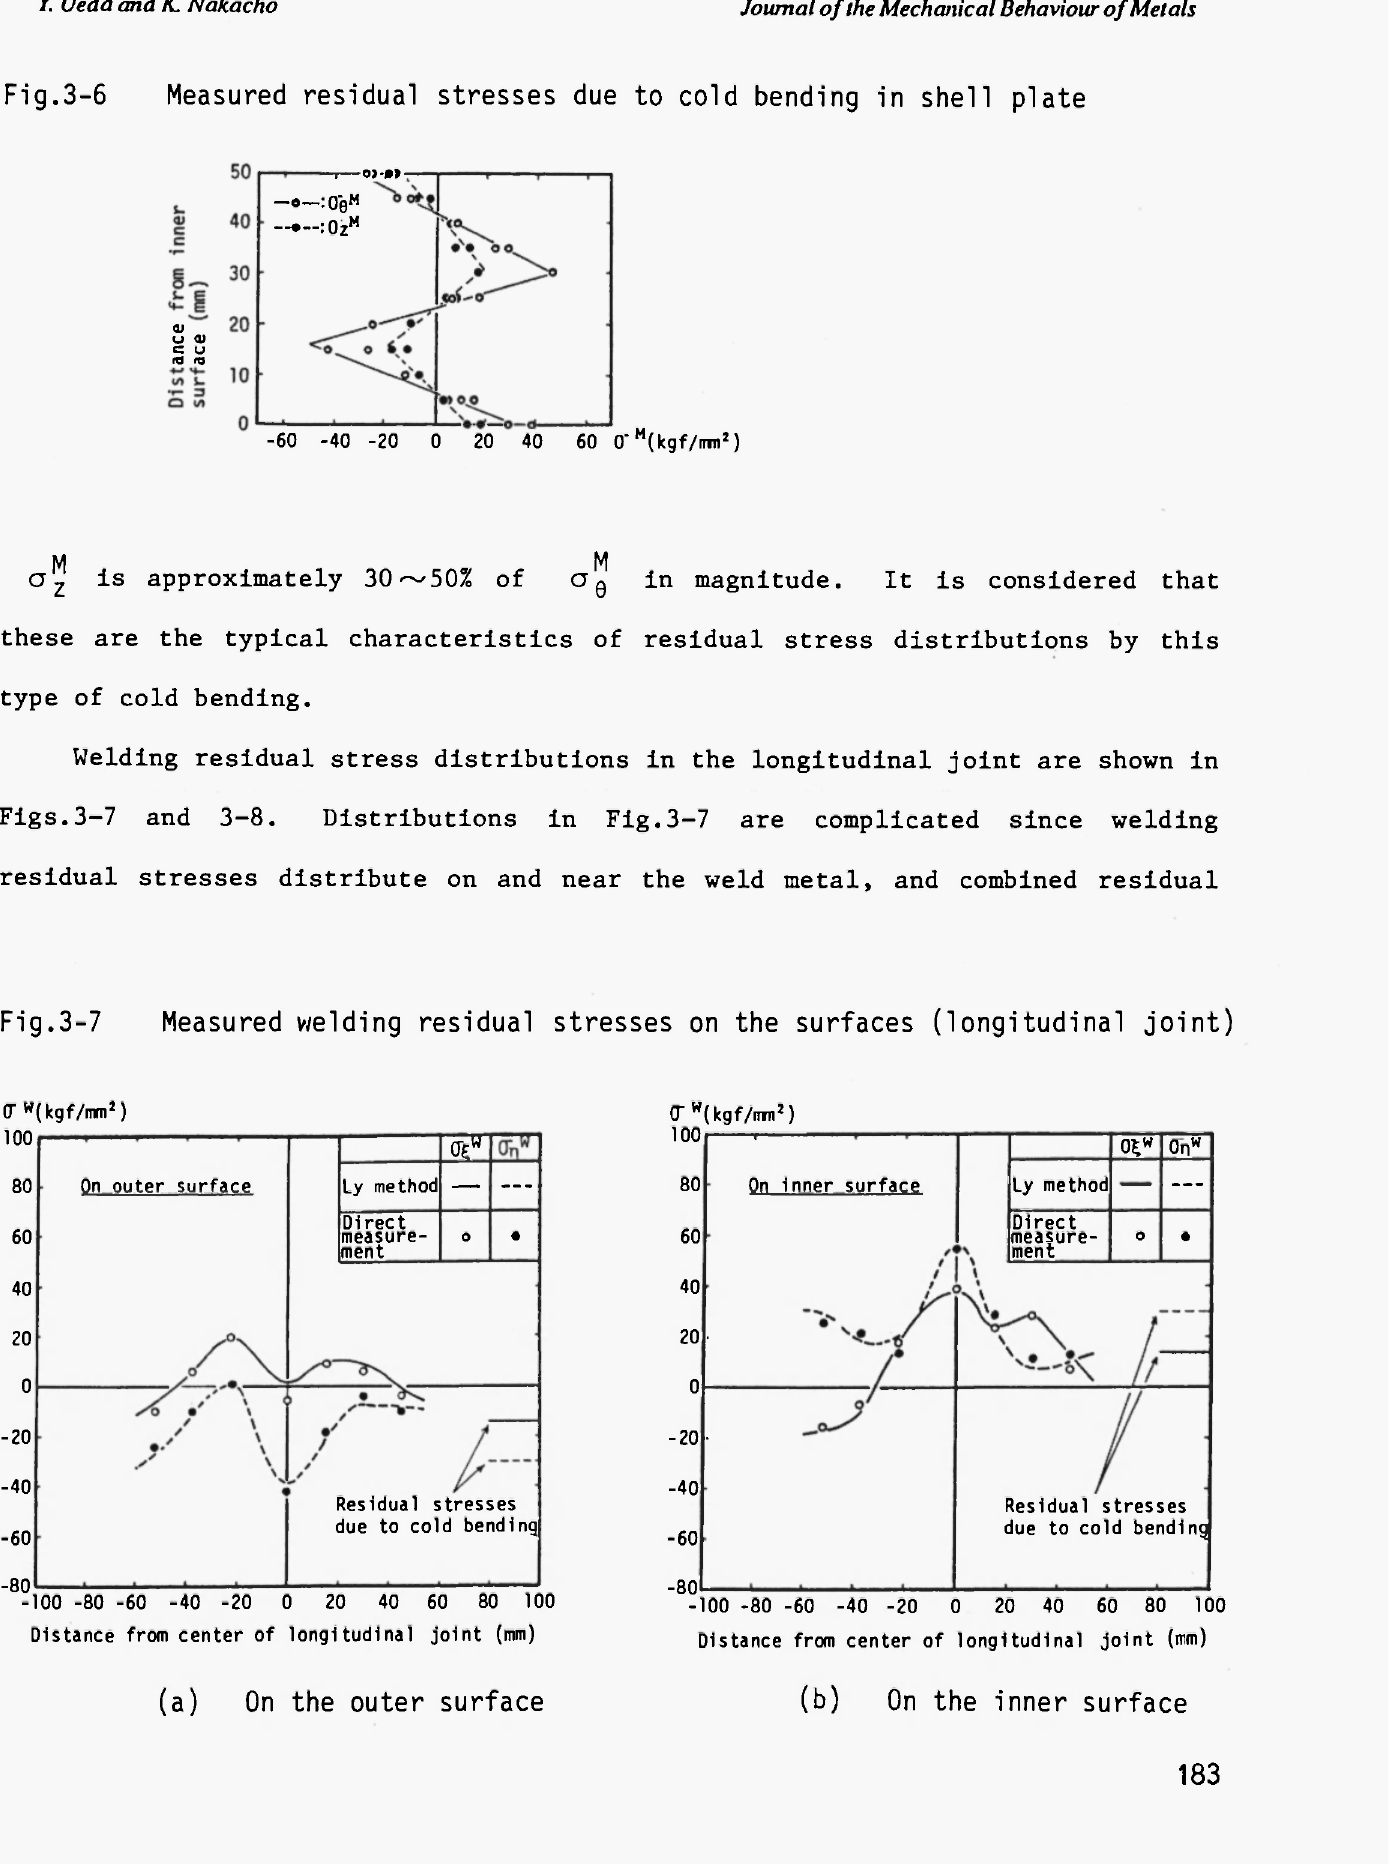
Measured welding residual stresses on the surfaces (longitudinal